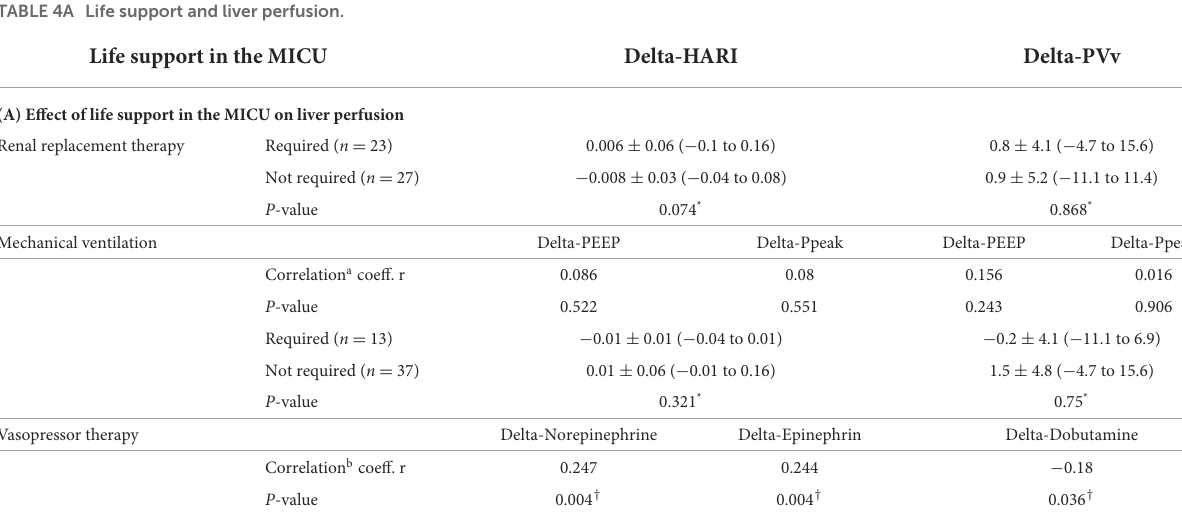
TABLE 4A Life support and liver